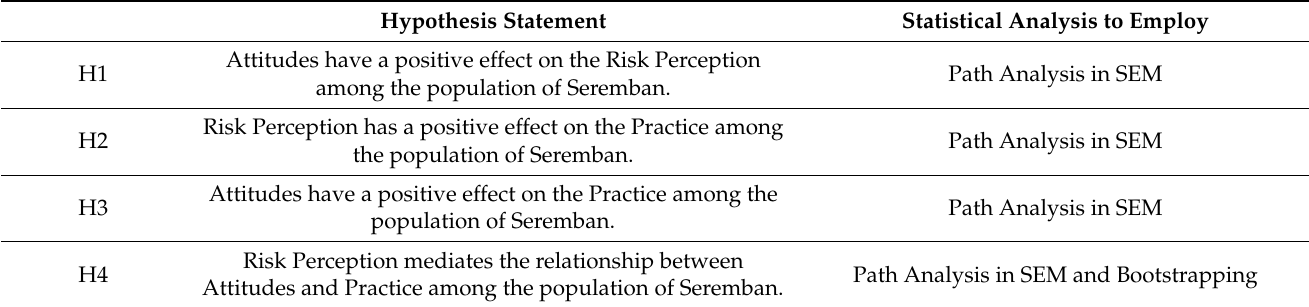
Table 1. Hypotheses of the study and method of